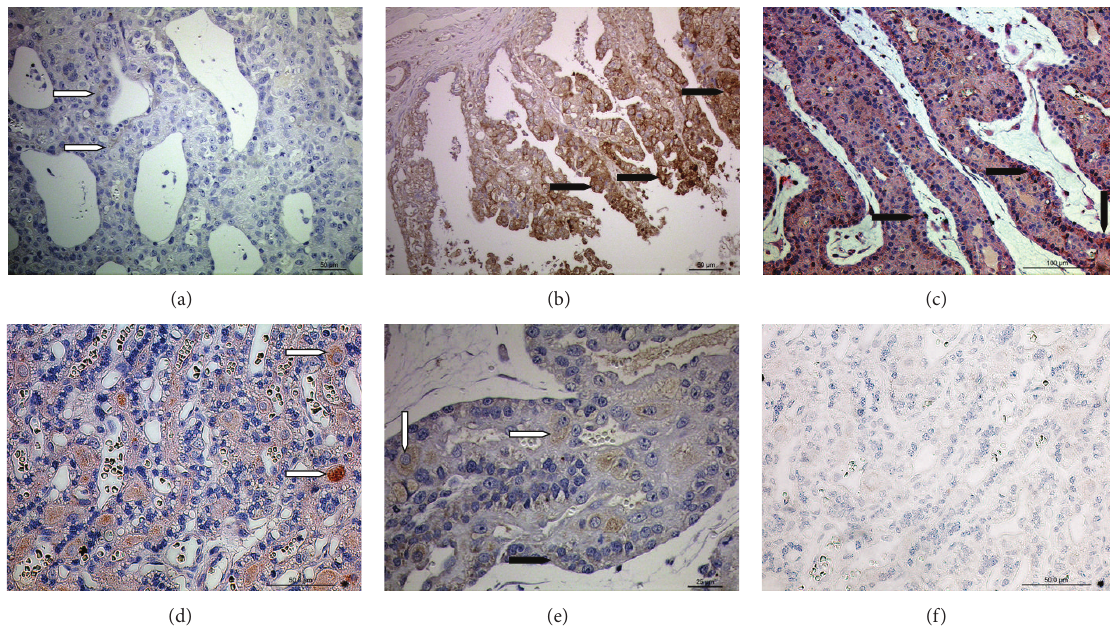
Figure 1: PGFS (AKR1C3) protein localization in the uteroplacental unit. Immunohistochemical (IHC) localization of PGFS in the week 2 of pregnant uterus (a) and placenta at week 3 (b), week 6 (c), and week 9 of gestation ((d), (e)). (a) In the feline uterus some weak PGFS signals are localized in the glandular epithelium (open arrowheads); ((b), (c)) in the placental labyrinth, PGFS expression is localized in the fetal trophoblast cells (solid arrowheads). ((d), (e)) In the fully developed placenta, towards the end of pregnancy, signals are weaker in trophoblast cells and are mostly localized in maternal decidual cells (open arrowheads). (f) Isotype